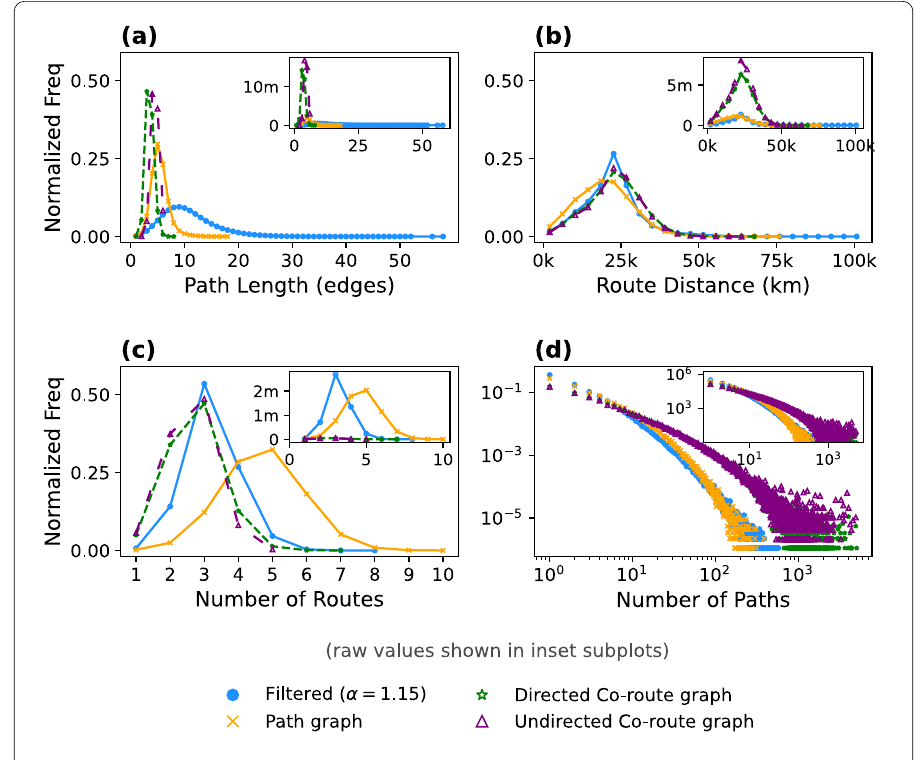
Figure 5 Filtered minimum-route paths more accurately capture how a container can move through the network based on liner shipping service routes. Path and route length statistics differ substantially between the filtered minimum-route paths (blue circles) and shortest paths through all of the path graph (orange crosses), the directed co-route graph (green stars), and the undirected co-route graph (purple triangles). Each panel shows a normalized histogram with an unnormalized version in the inset plot. Network path lengths ( a ): Minimum-route paths are much longer (mean 20 edges) than the shortest paths through the undirected (3.5) or directed (3.5) co-route graph and the path graph (mean 5.4). The mean shipping distance ( b ) for the minimum-route paths (mean 21,861.3 km) is shorter than that of the undirected (22,784.05) and directed (22,767.85) co-route graphs, but distribution for the minimum-route paths has a longer tail. The minimum-route paths are longer than shortest paths through the path graph, both in terms of mean (19,532.4) and maximum distance. The number of routes required ( c ) for the filtered paths (mean 3.2 routes) is shorter than in the path graph (4.7), where each shortest path may use a different number of routes. Only 0.3% of the shortest paths through the undirected and 0.4% of paths through the directed co-route graph are viable based on the shipping routes, but those that do correspond to viable paths use the minimum number of routes (means 2.6 and 2.7, respectively). Finally, the number of paths per pair of ports ( d ) is reduced substantially in the path graph and filtered minimum-route